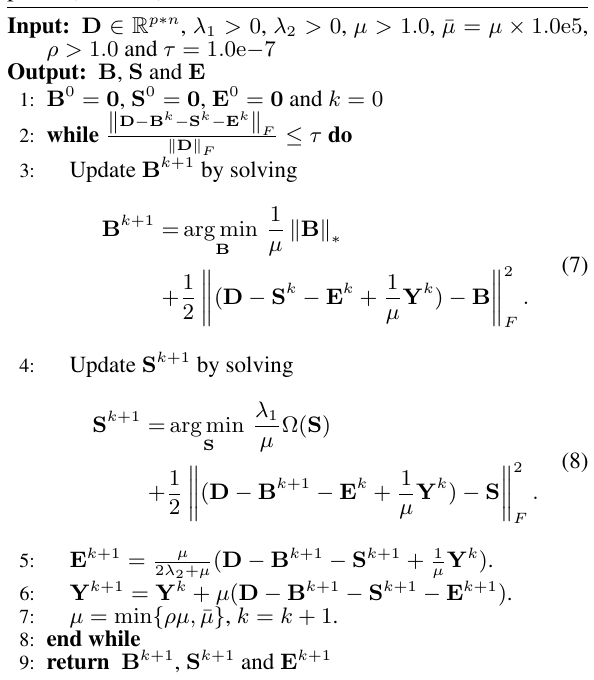
Algorithm 1 The Alternating Direction Method of Multi- pliers (ADMM) for